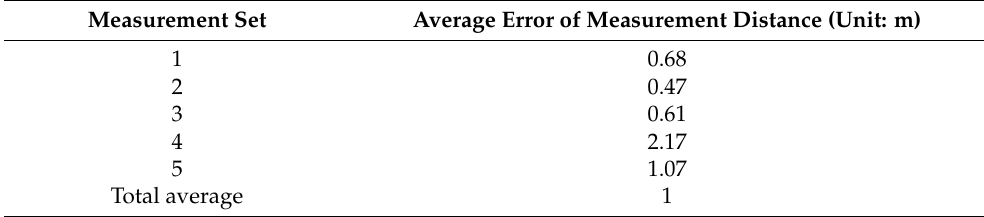
Table 3. Average error of measurement distance combined with beacon, PDR and vision positioning